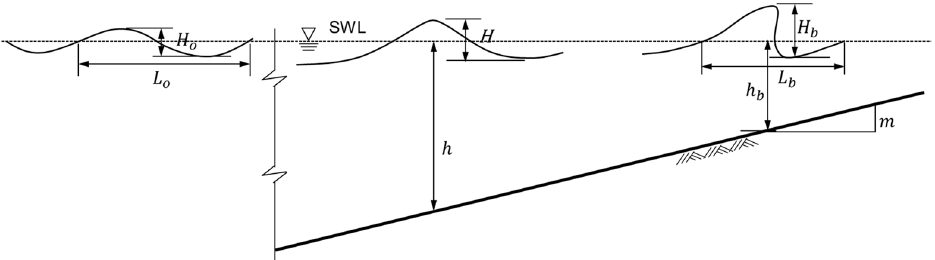
Figure 1. Definition sketch of wave at incipient breaking.